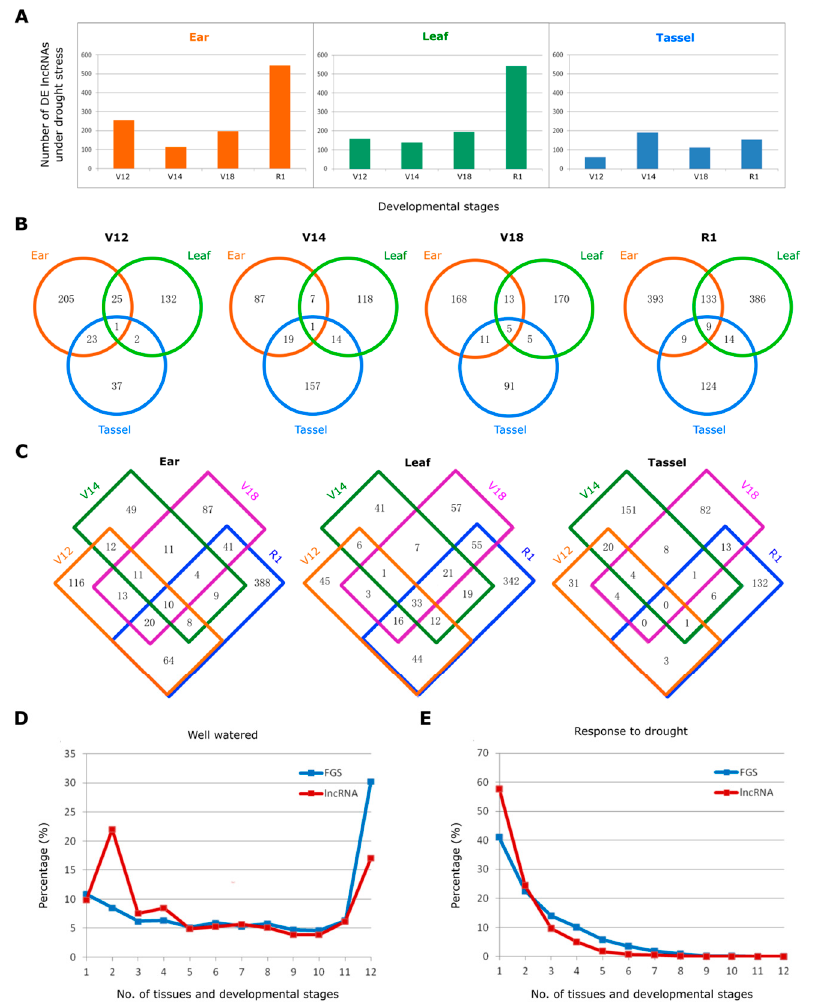
Figure 2. Identification of drought responsive lncRNAs and their tissue- and developmental specificity of expression. ( A ) Number of differentially expressed lncRNAs under drought stress in ear, leaf, and tassel. ( B ) Venn diagram showing the lncRNAs differentially expressed in the three tissues (ear, leaf, tassel) at four developmental stages (V12, V14, V18, R1). ( C ) Venn diagram showing the lncRNAs differentially expressed at the four developmental stages (V12, V14, V18, R1) in each tissue (ear, leaf, tassel). ( D ) Tissue/development-specific expression of the lncRNAs and FGS transcripts under the well-watered condition. The number on the x -axis, ranging from 1 to 12, represent how many tissue types and developmental stages genes are expressed in, for example, “1” stands for genes expressed in a single tissue at a single developmental stage, while “12” refers to genes expressed ubiquitously in all three tissues at all four developmental stages examined. ( E ) Tissue/development-specificity of the drought responsive lncRNAs and the drought responsive FGS transcripts. The meaning of the numbers on the x -axis is the same as on ( D